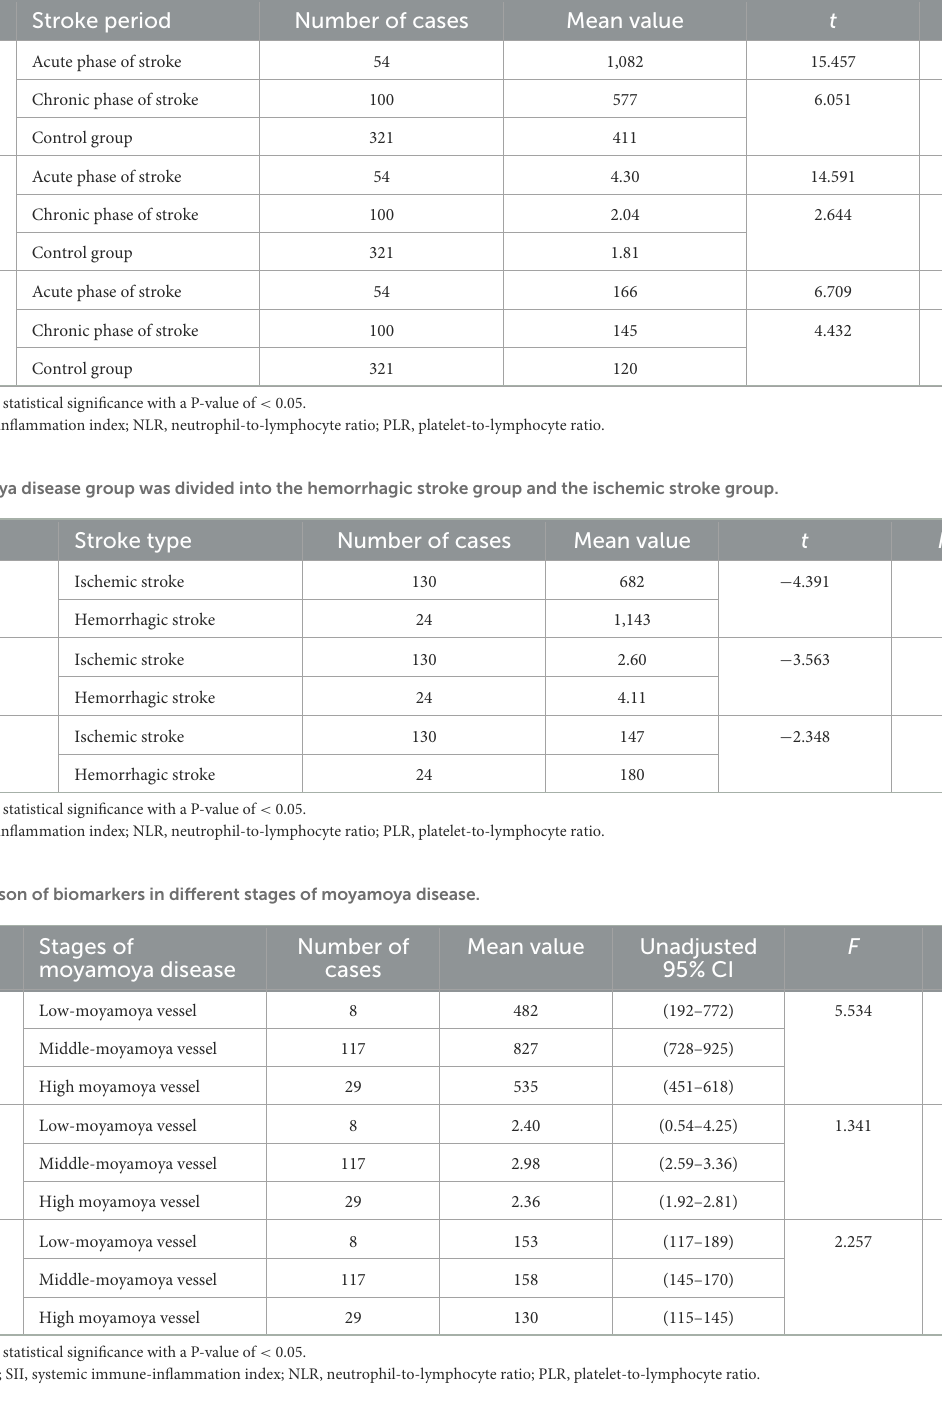
TABLE 2 Moyamoya disease group was divided into acute and chronic phase groups and compared with the control group, respectively.